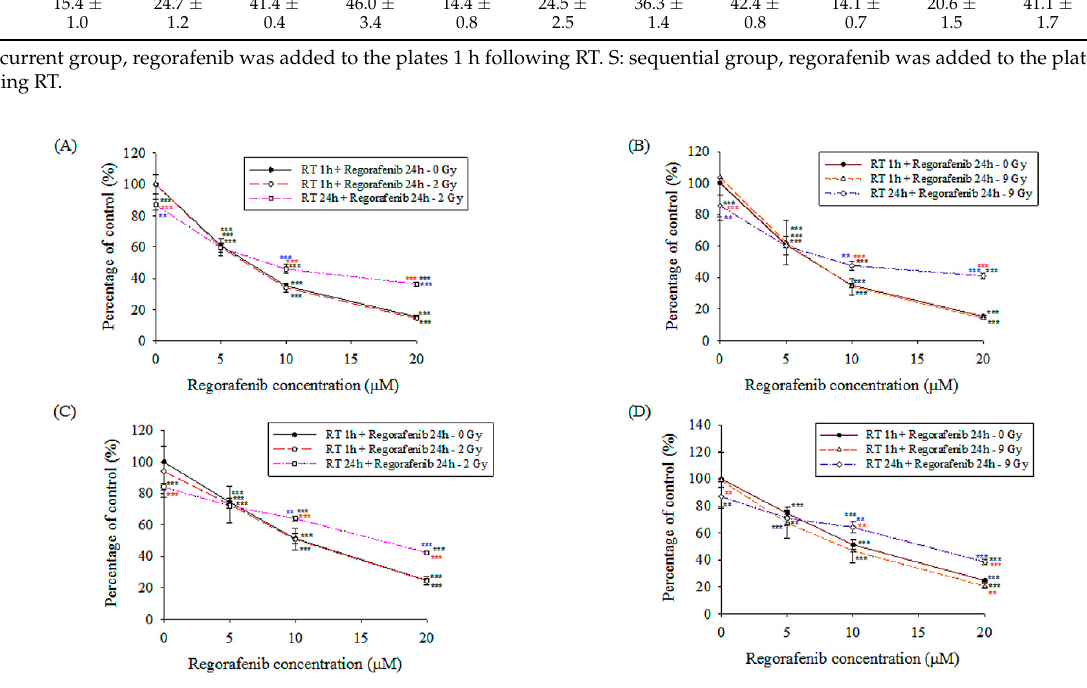
Figure 5. Huh-7 and Hep G2 cells were seeded into 96-well plates (1 × 10 3 per well) in 100 µ L of serum-containing medium and allowed to grow for 1 day. Concentrations of 0, 5, 10 and 20 µ mol/L ( µ M) regorafenib were added to the plates, 1 h following irradiation (concurrent group) or 24 h following irradiation (sequential group), with sham RT (RT 0 Gy ), 2 Gy (RT 2 Gy ) and 9 Gy (RT 9 Gy ). ( A ) Huh-7 cells treated with RT 2 Gy ; ( B ) Huh-7 cells treated with RT 9 Gy ; ( C ) Hep G2 cells treated with RT 2 Gy ; ( D ) Hep G2 cells treated with RT 9 Gy . Data from three separate experiments are expressed as the mean ± standard error of the mean (SEM). Black asterisk (*): all vs. 0 Gy + 0 mM. Red asterisk (*): RT 1 h + regorafenib 24 h or RT 24 h + regorafenib 24 h vs. 0 Gy in different concentrations. Blue asterisk (*): RT 1 h + regorafenib 24 h vs. RT 24 h